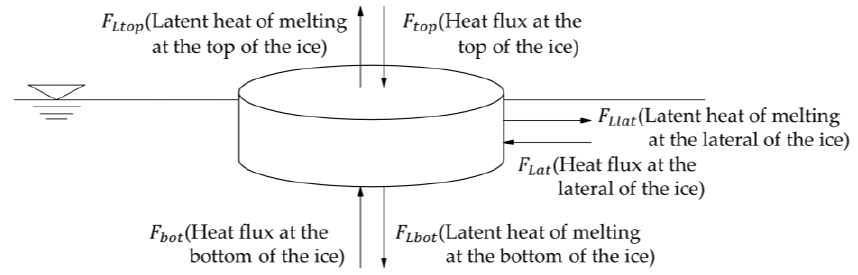
Figure 1. Thermal balance between the ice–air interface at the surface, between ice and water on the bottom, and the lateral surface of a floe.